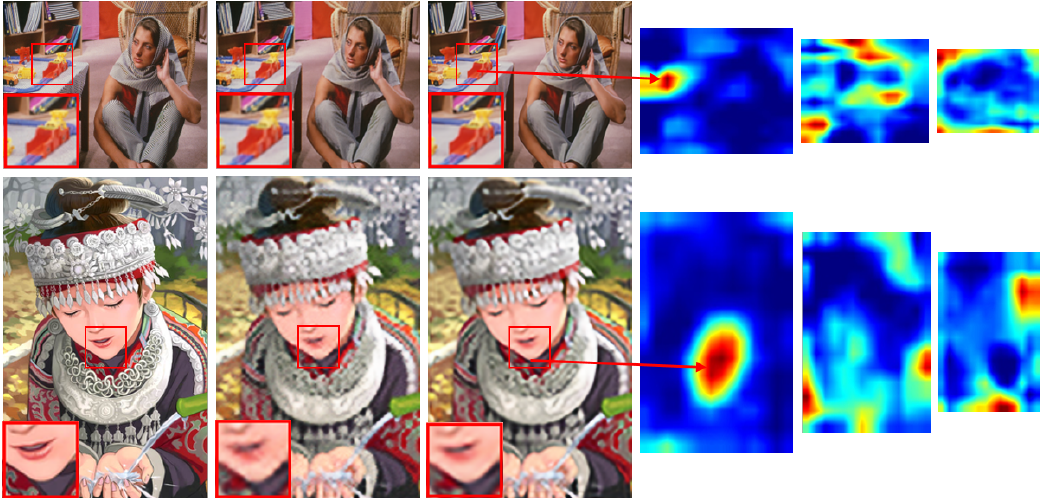
Figure 6. The ablation studies of RSA unit for reconstruction. The images from left to right correspond to ground truth, PM-DAN without RSA units, PM-DAN, and the predicted spatial attention maps by RSA units at multiple scales.